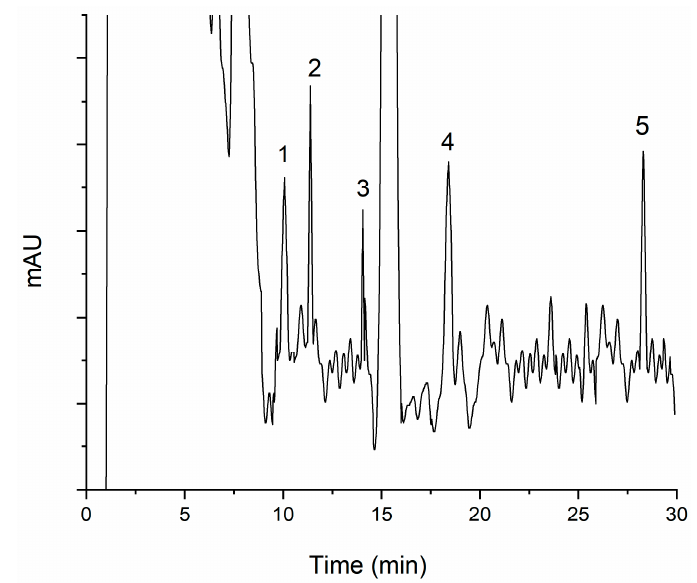
Figure 6. Typical chromatogram of five pyrethroids in Qutanling oral liquids under optimum conditions: (1) transfluthrin, (2) fenpropathrin, (3) fenvalerate, (4) etofenprox, and (5) silafluofen. The chromatogram was obtained at the LOD level (0.02 ng mL − 1 ).